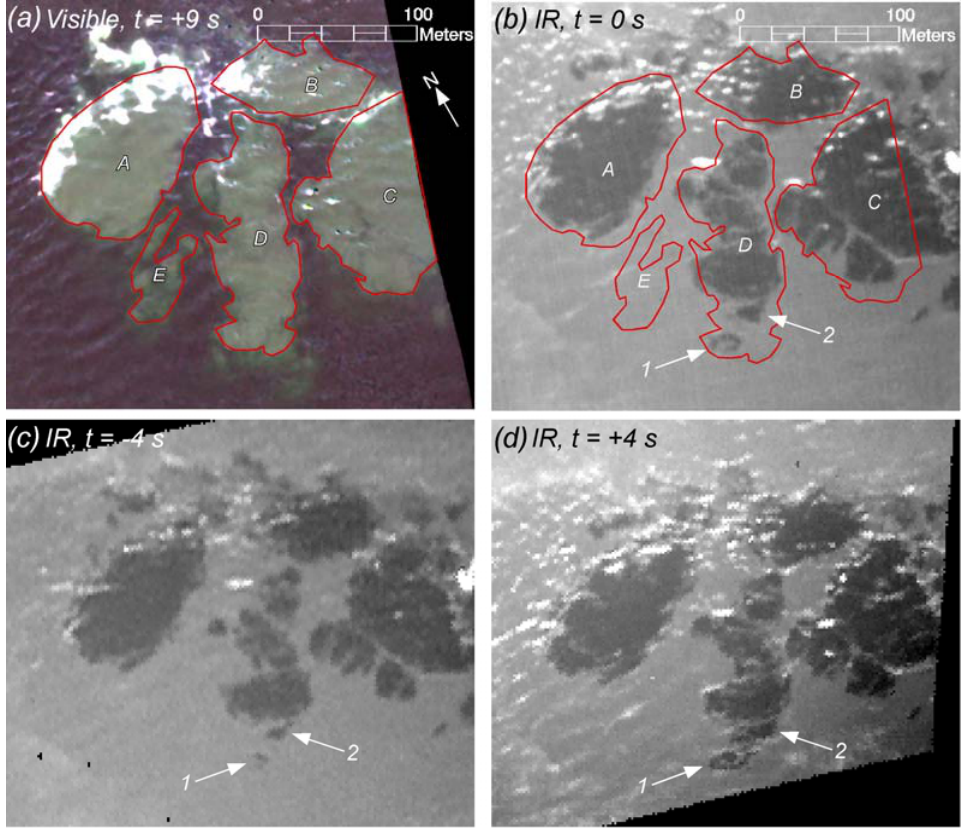
Figure 7. ( a , b ) Enlarged views of the visible and thermal signatures highlighted in Figure 5. Visible boil patches A to E (a) are outlined in red; the same red outlines are repeated in (b). Image acquisition time, t , is measured relative to panel (b). The boils are about 0.4 °C colder than the surrounding water; ( c , d ) IR data showing the same boils 4 s before and after panel (a). Black dots (e.g., panel (c), lower left corner) are bad camera pixels and should be ignored. Features 1 and 2 illustrate cold imprints that grow over